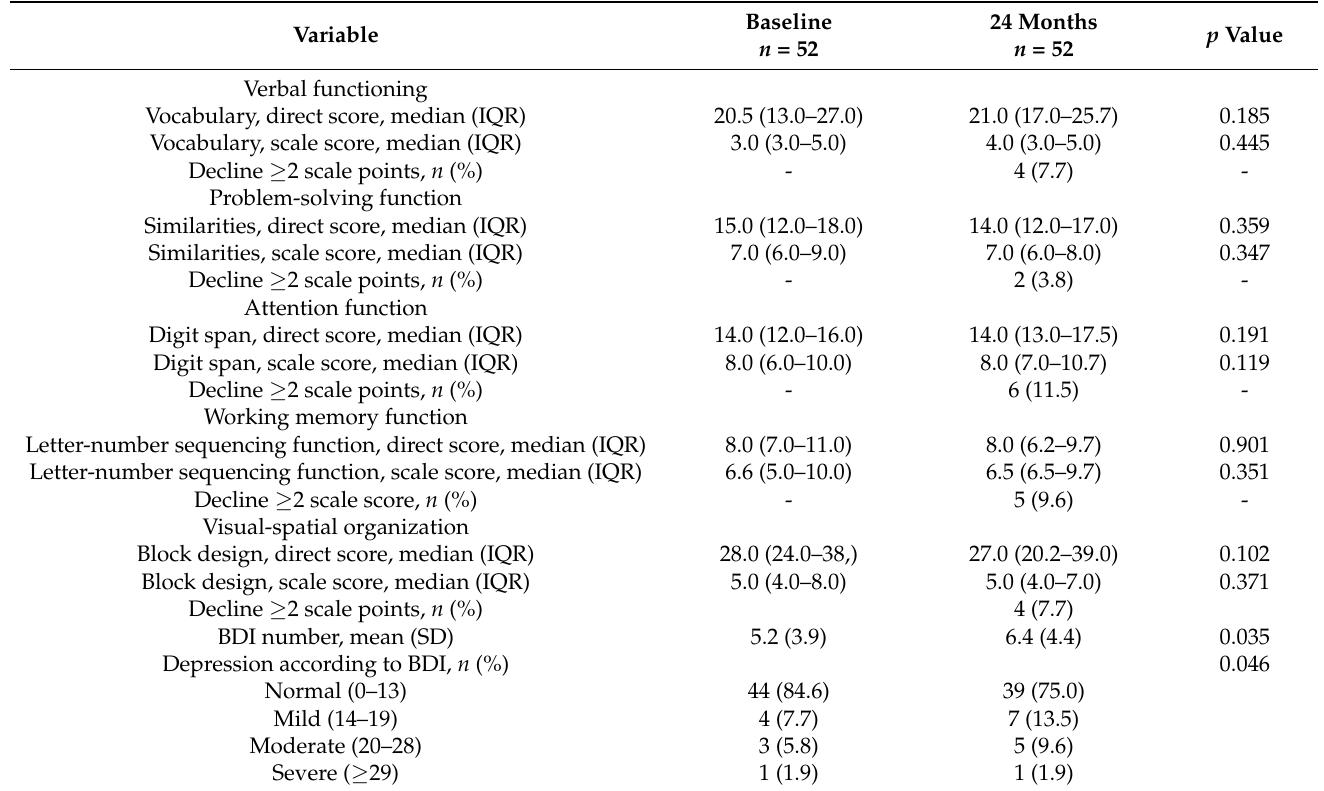
Table 2. Cognitive function at baseline and at 24 months in patients with